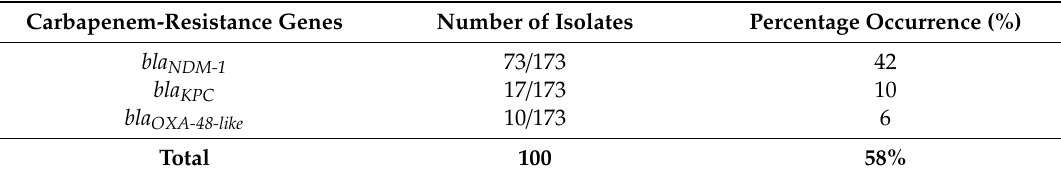
Table 4. Distribution of carbapenem-resistance genes identified among carbapenemase-producing Enterobacteriaceae.